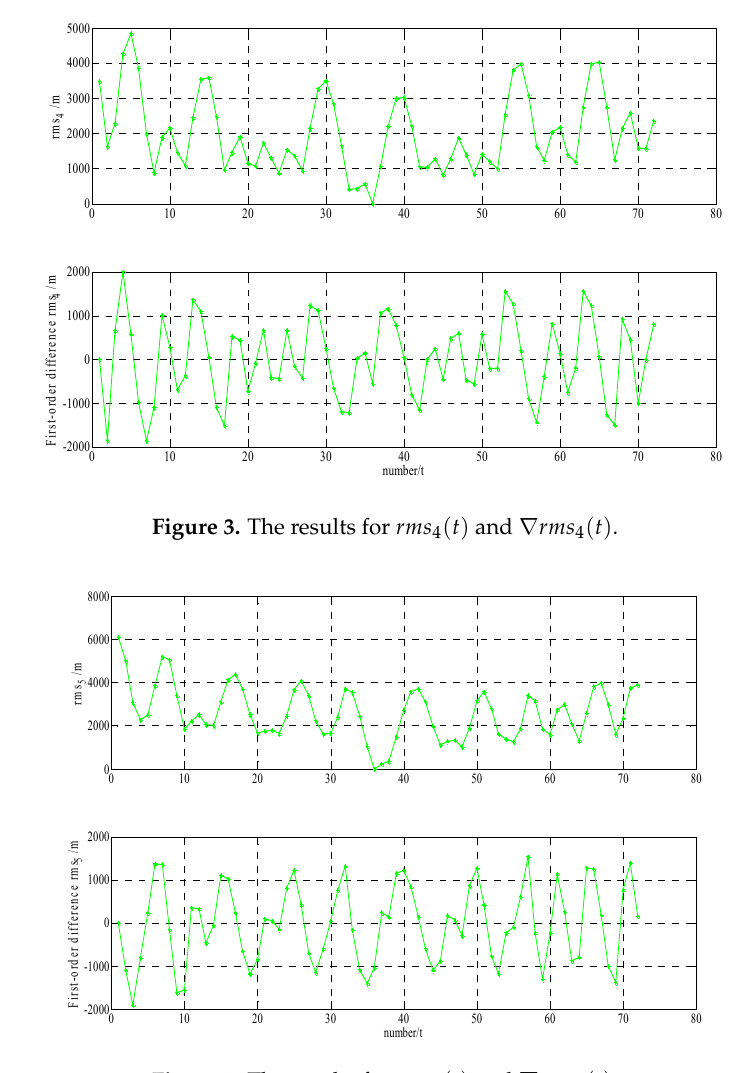
Figure 4. The results for